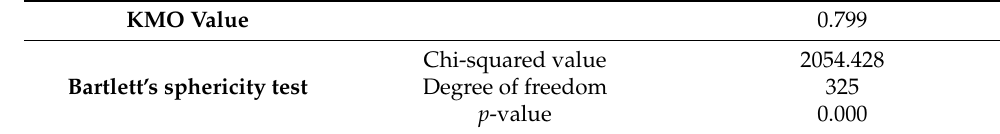
Table 3. Results of the validity